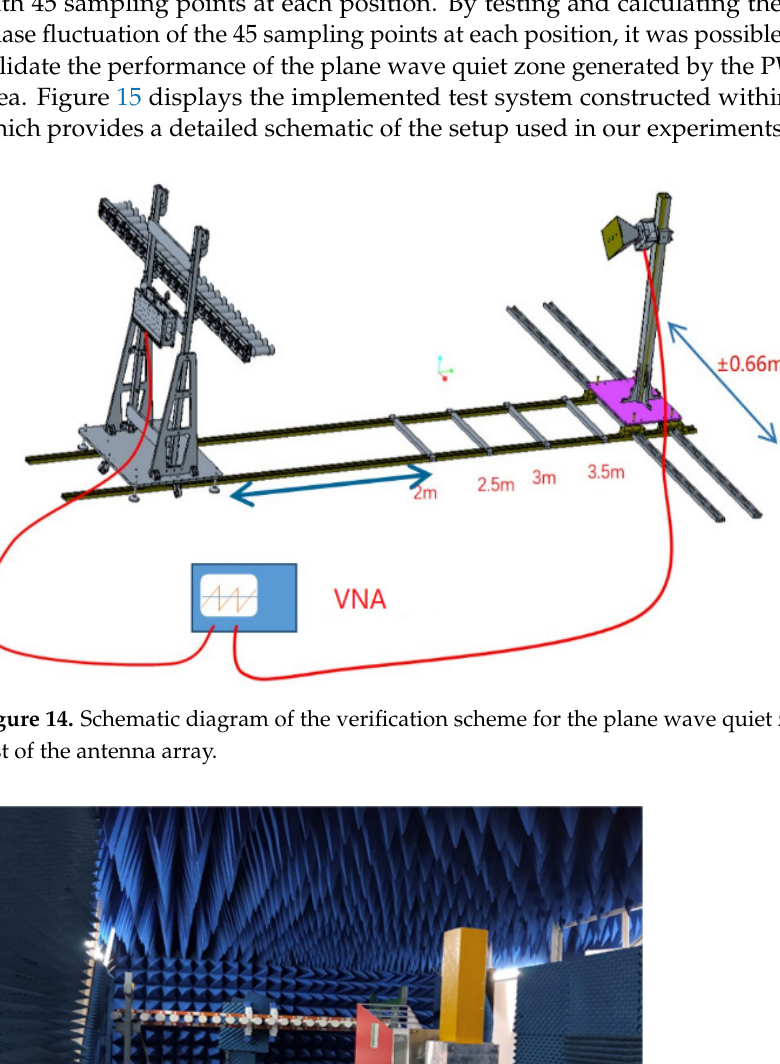
Figure 13. Phase variation of composite pattern fields at different frequency points on observation lines at different distance (2m, 2.5m, 3m, and 3.5 m). ( a ) 700 MHz–2.0 GHz. ( b ) 2.0–3.0 GHz. ( c ) 2.0– 3.0 GHz.